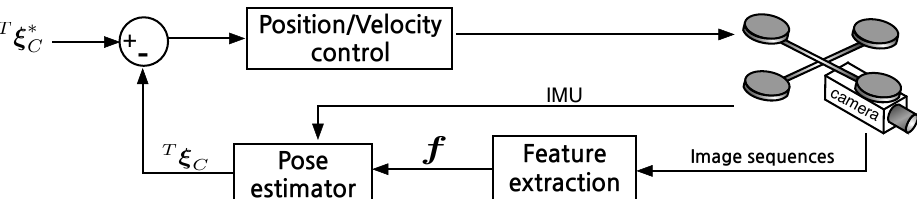
Figure 5. Position-based visual servoing diagram. f is a feature vector. T ξ the estimated and the desired pose of the target with respect to the camera.